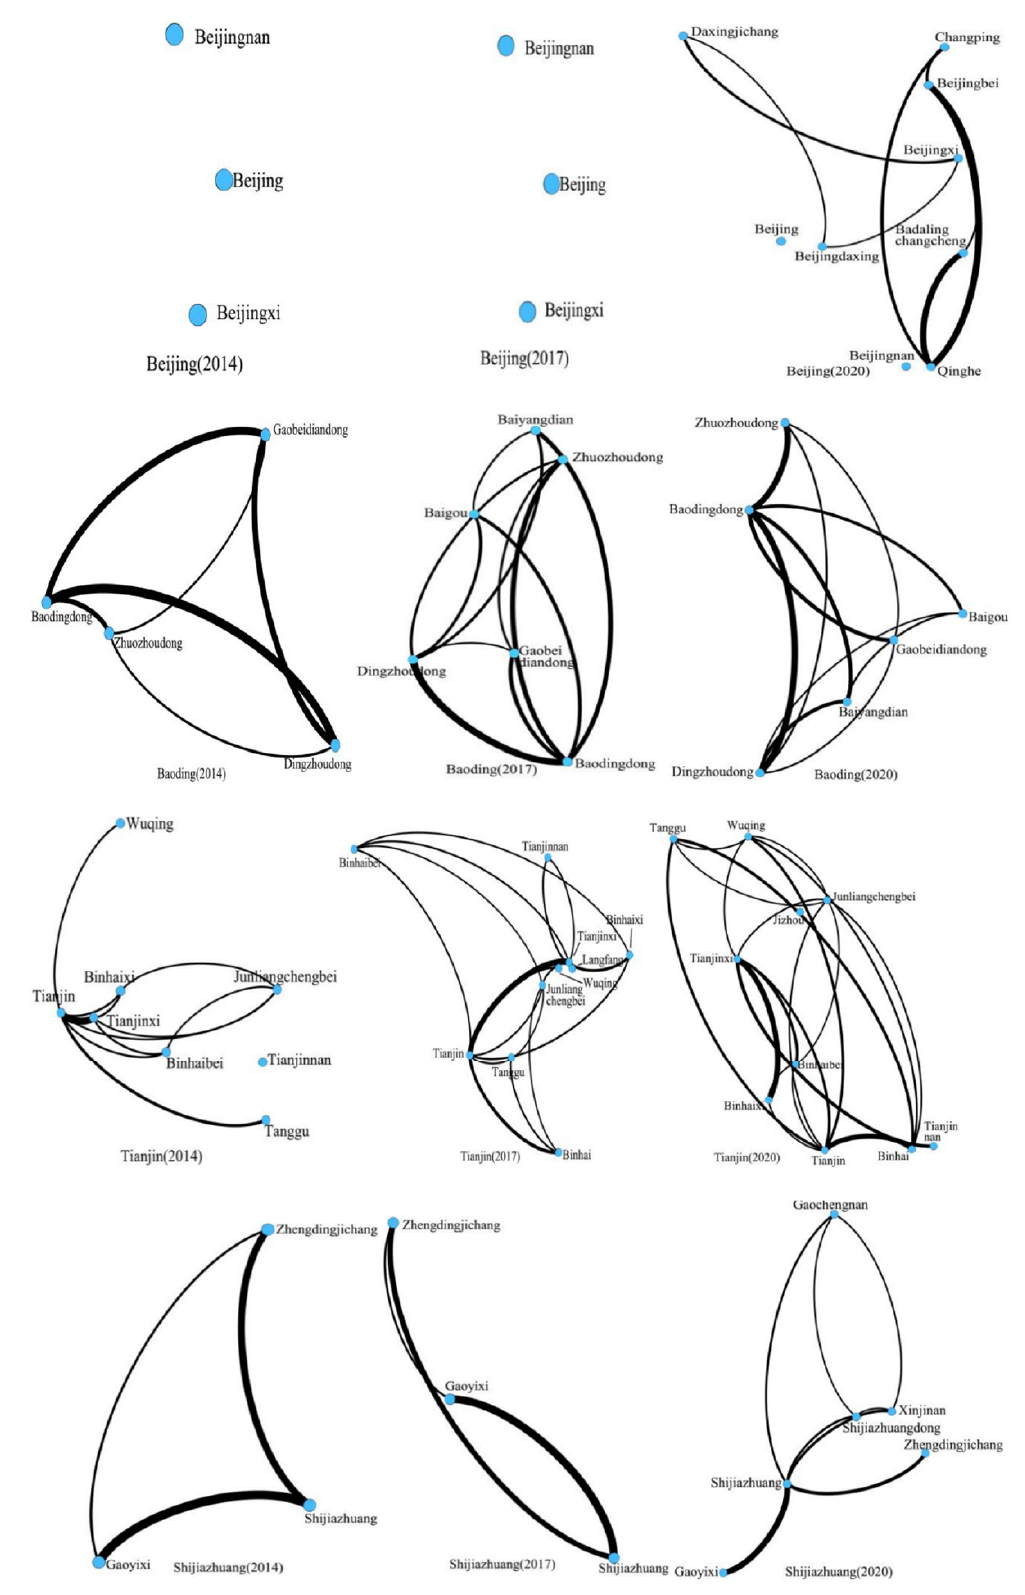
Figure 7. Comparison of the structure of internal HSR networks in four cities. Note: The blue points mean the HSR stations, and the black lines mean the simulated HSR passenger flows.